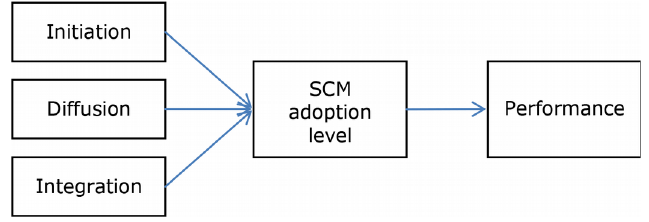
Figure 1. Level of adoption SCM and